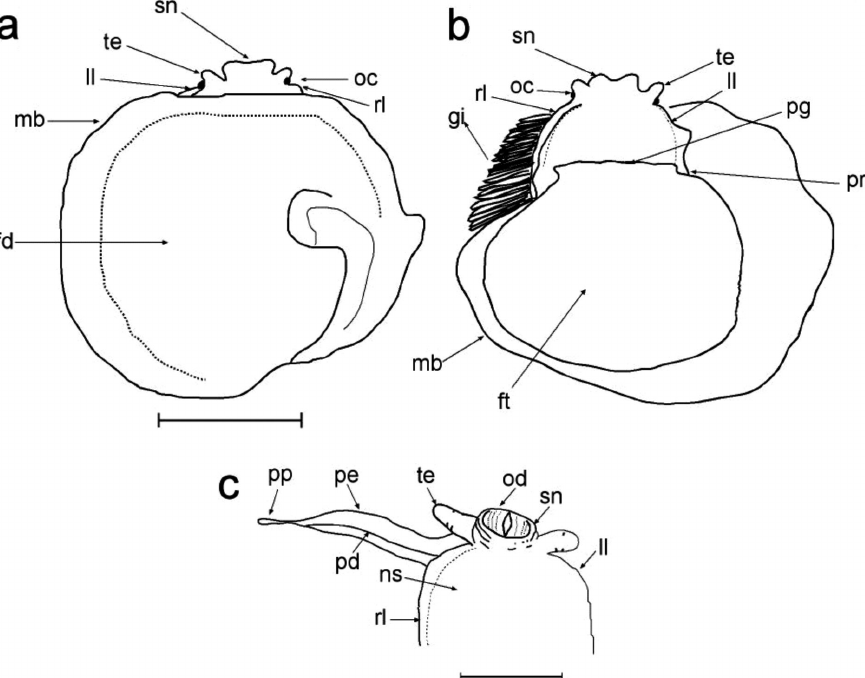
Figure 7. External morphology of Calyptraea aurita . a female, without shell and whole, dorsal view b same animal, whole, ventral view c male, foot removed, ventral view. Abbreviations: fd: dorsal surface of foot; ft: foot; gi: gill; ll: left lateral expansion (flan); mb: mantle border; ns: neck “sole”; pd: penis sperm groove; pe: penis; pg: pedal gland anterior furrow; pp: penis papilla; pr: propodium; rl: right lateral expan- sion (flan); sn: snout–proboscis; te: cephalic tentacle. Scale bar: 10 mm ( a, b ), 5 mm ( c